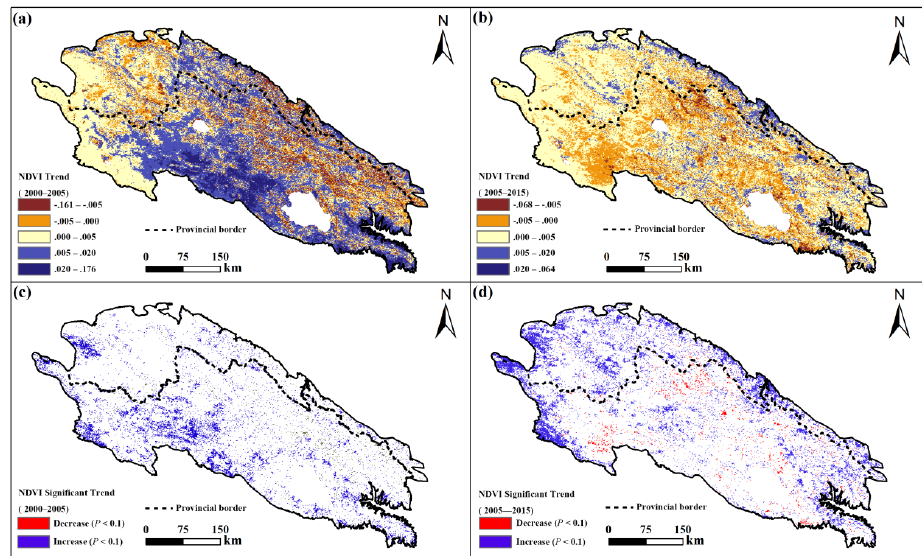
Figure 6. Growing season NDVI trends obtained by linear regression, and significance levels obtained by Mann–Kendall tests for the QLM from 2000 to 2015: ( a ) NDVI trend from 2000 to 2005; ( b ) NDVI trend from 2005 to 2015; ( c ) significance level for the NDVI from 2000 to 2005; ( d ) significance level for the NDVI from 2005 to 2015. The blank regions in the QLM in c and d indicate a nonsignificant change in NDVI ( p > 0.1).